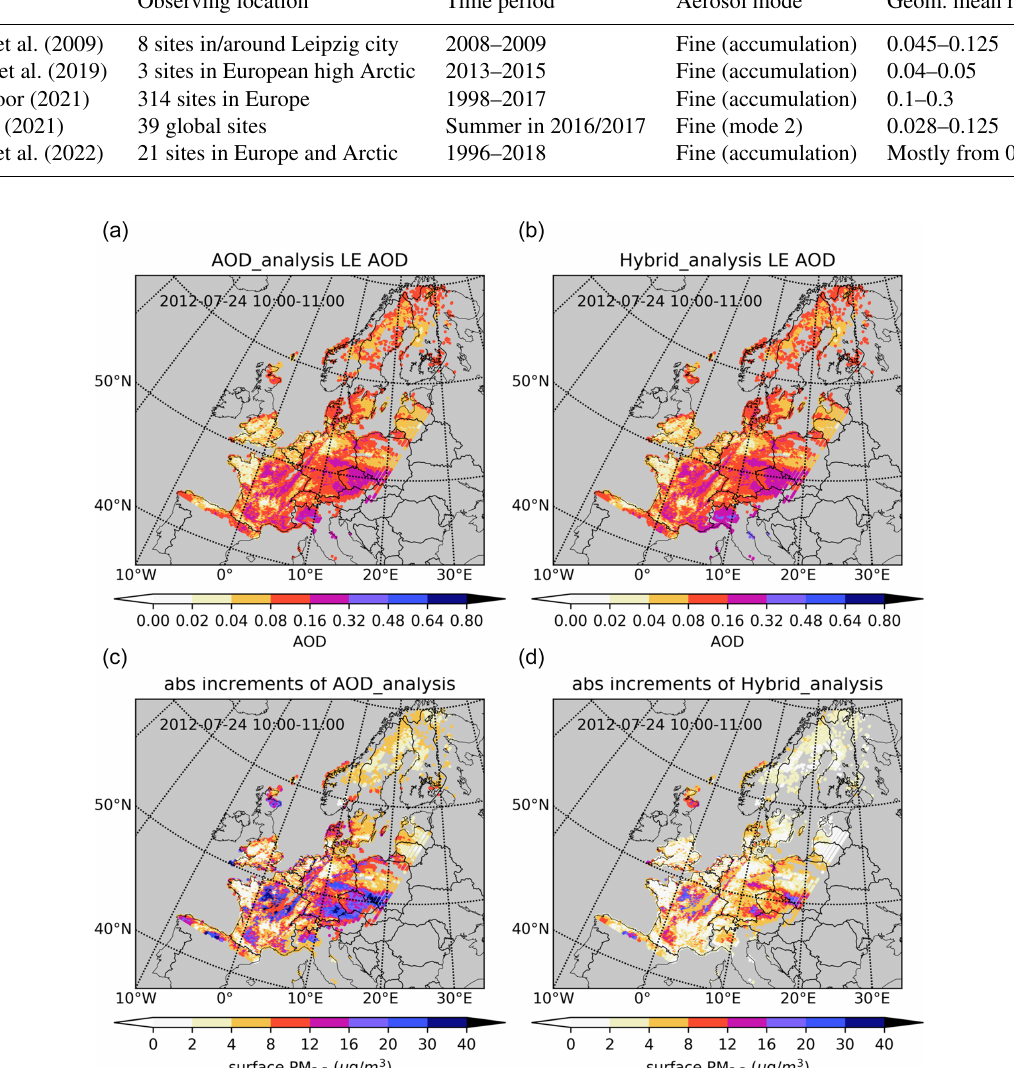
Figure 8. Posterior AOD simulations (a, b) and increments of surface PM 2 . 5 concentrations (c, d) in either AOD assimilation (a, c) or hybrid assimilation (b, d) on 24 July, 10:00 to